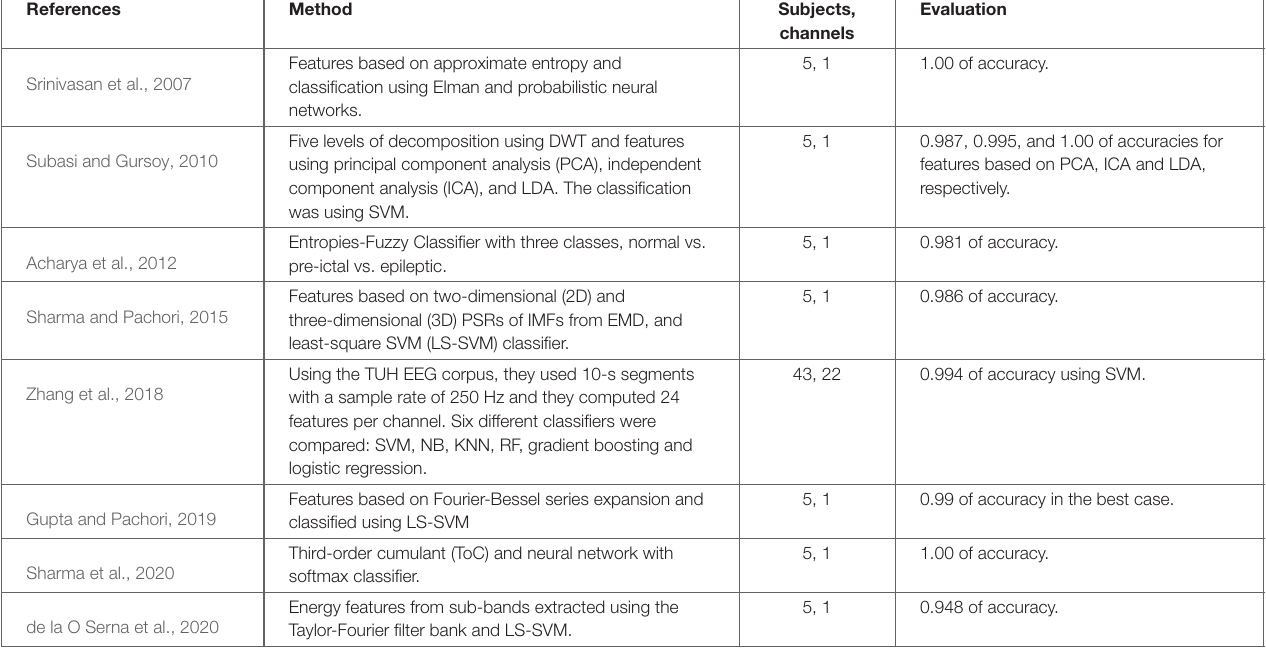
TABLE 6 | Comparison of some relevant existing methods for epileptic seizures classification using different